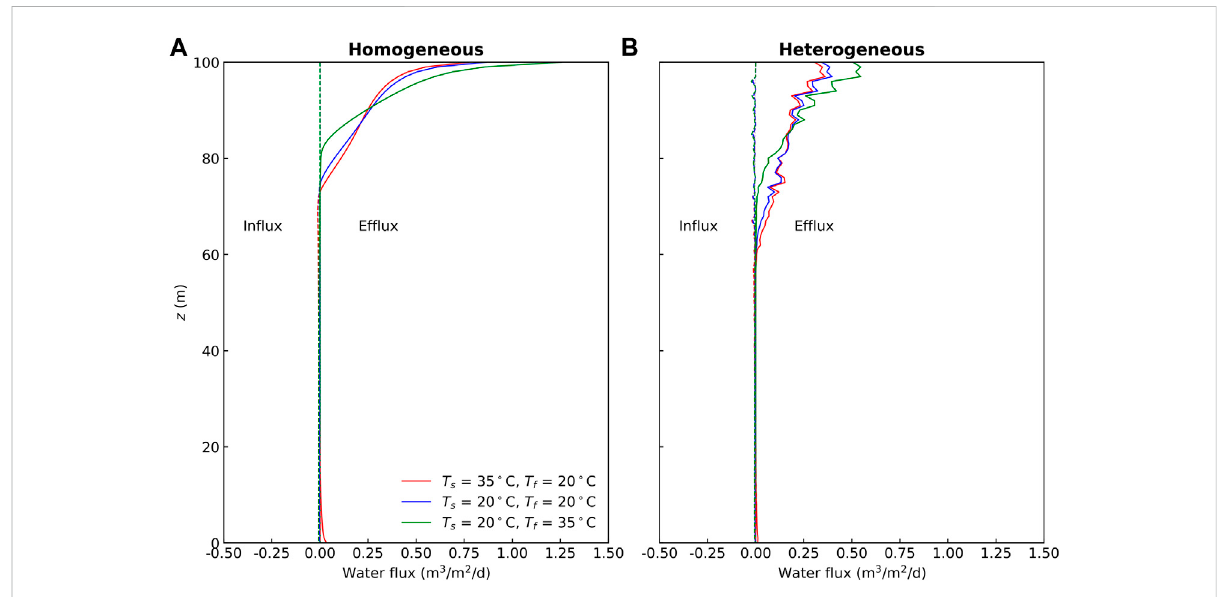
FIGURE 5 Per-unit-area water fl ux across seaward boundary in (A) homogeneous and (B) heterogeneous con fi ned aquifers. The results of different FW- SW temperature contrasts are indicated by lines with different colors. The results for heterogeneous aquifers ( σ 2 ln k = 1 and λ x = 0.5 m) are averaged ( n = 50). T s and T f are seawater and freshwater temperatures,